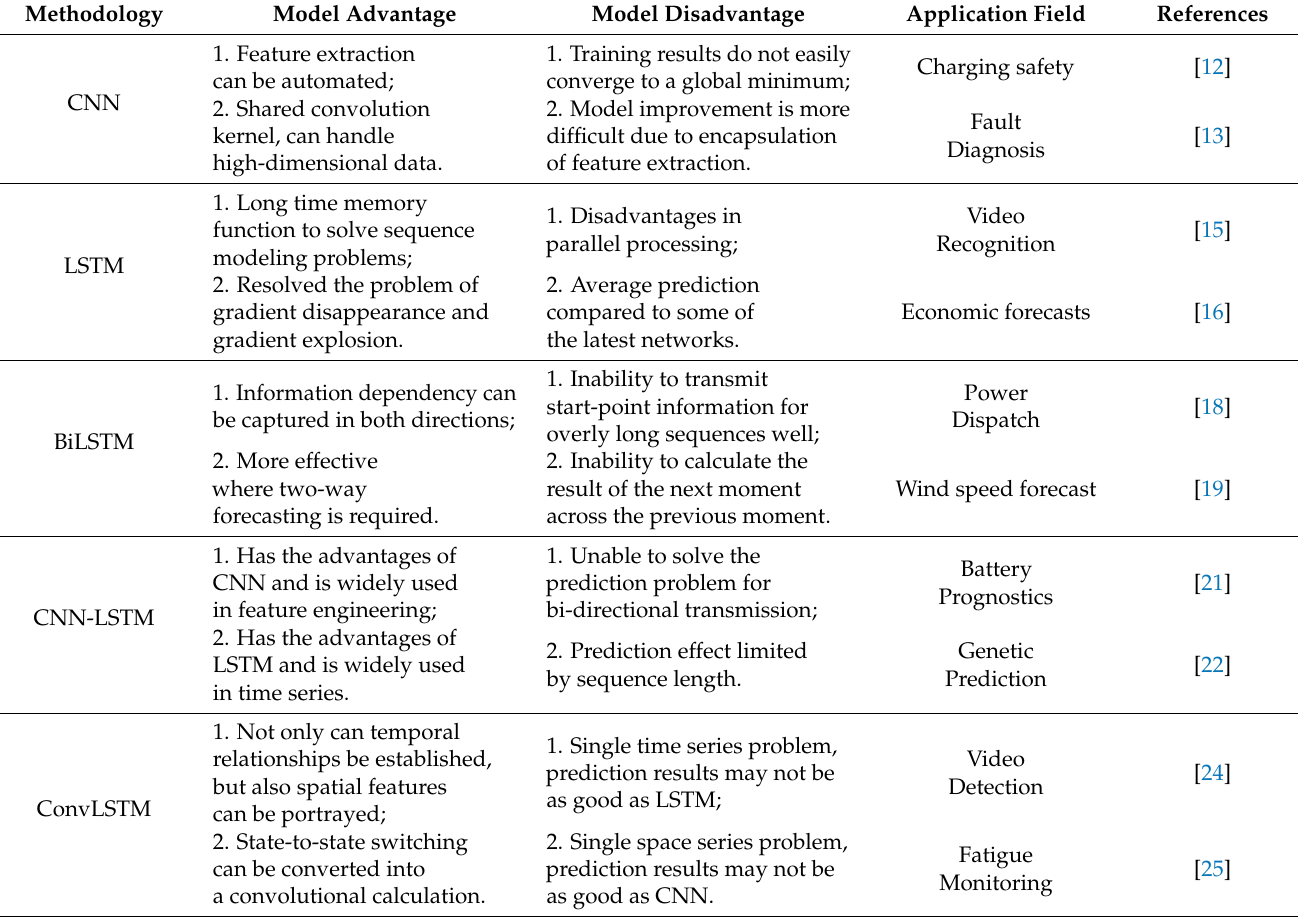
Table 3. Comparison of the advantages and disadvantages of different